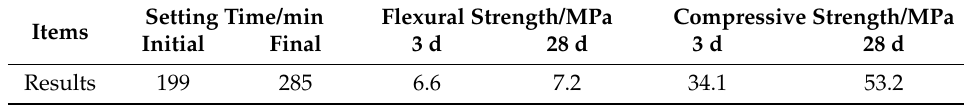
Table 1. Physical properties of cement.